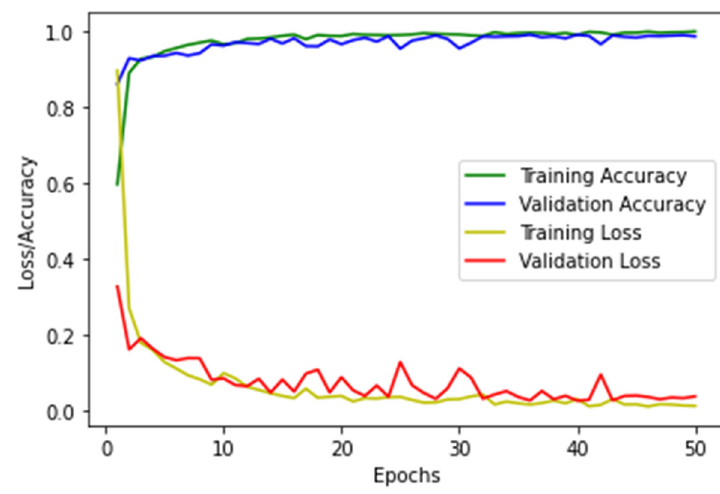
Figure 10. Training and validation progress of basic CNN.